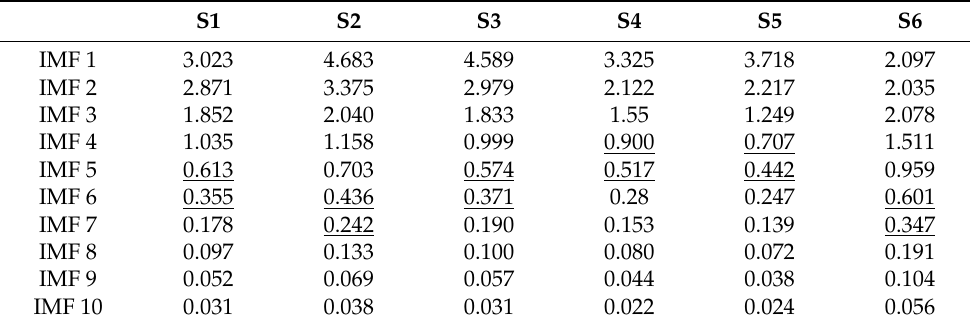
Table 3. Average Frequencies of Each Decomposed